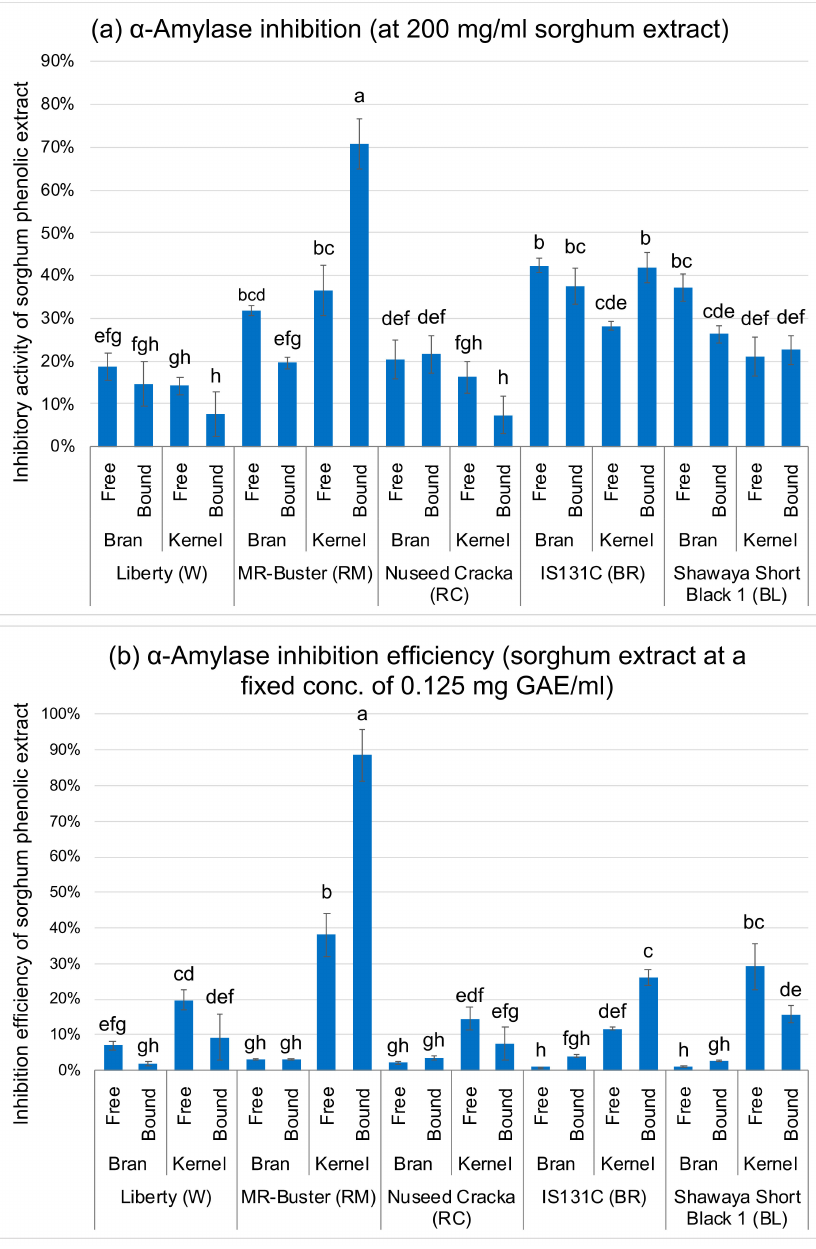
Figure 3. α -Amylase inhibitory activity ( a ) and the inhibition e ffi ciency ( b ) of sorghum phenolic extracts. Inhibition e ffi ciency is the inhibitory activity of phenolic extract at a fixed phenolic concentration, equals to the inhibitory activity of each extract sample divided by its total phenolic content. Error bars indicate ± standard deviation ( n = 3). Bars with di ff erent small letters are significantly di ff erent ( p <